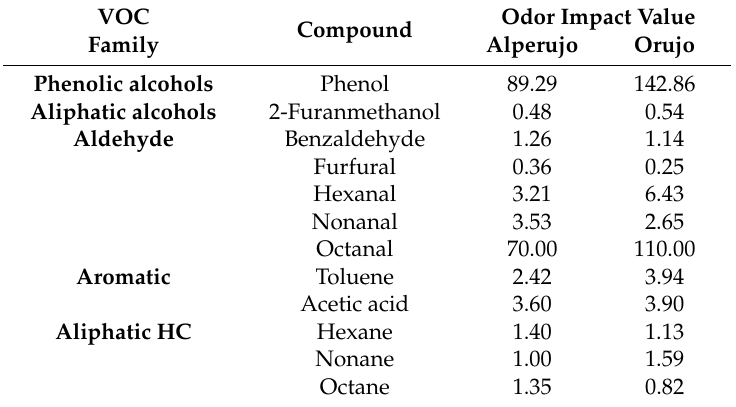
Table 6. Odor impact value (OIV) for the individual VOCs based on average samples of alperujo and orujo over